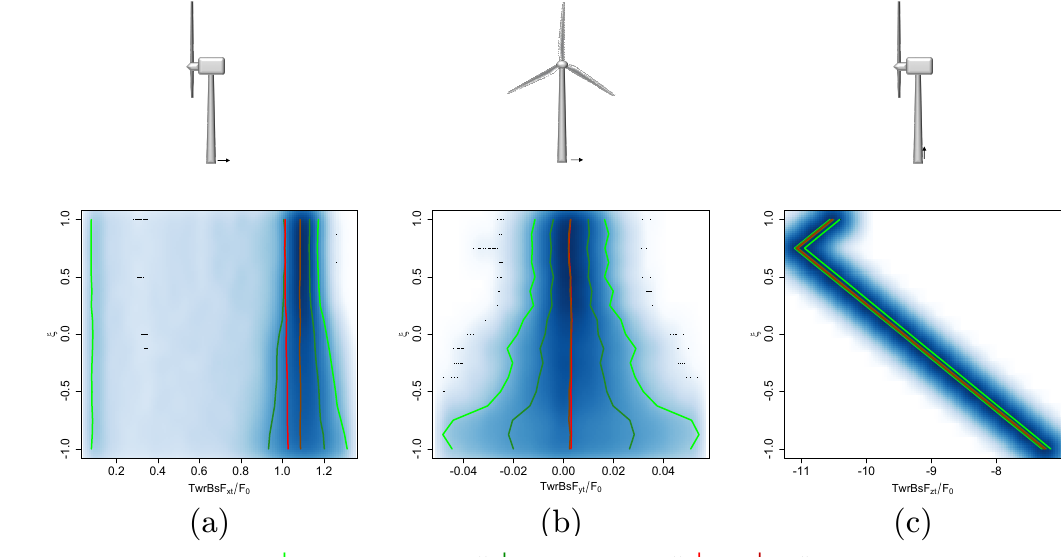
Figure 7. Variation with ξ of the PDFs of the tower base’s forces. (a) Streamwise shear. (b) Spanwise shear. (c) Traction–compression. The parameter ξ is represented by the vertical axis, starting with an entirely positive shear at the bottom (where ξ = − 1) and ending with an entirely negative shear at the top (where ξ = 1). The horizontal axis represents values of the tower base’s forces (TwrBsF) normalized by a reference ( F 0 ). The background color is deeper where values are more concentrated. The red line and the dark red line connect the mean and the median values, respectively. The green lines and the dark green lines delimit the zones encompassing 95 and 68% of the values,